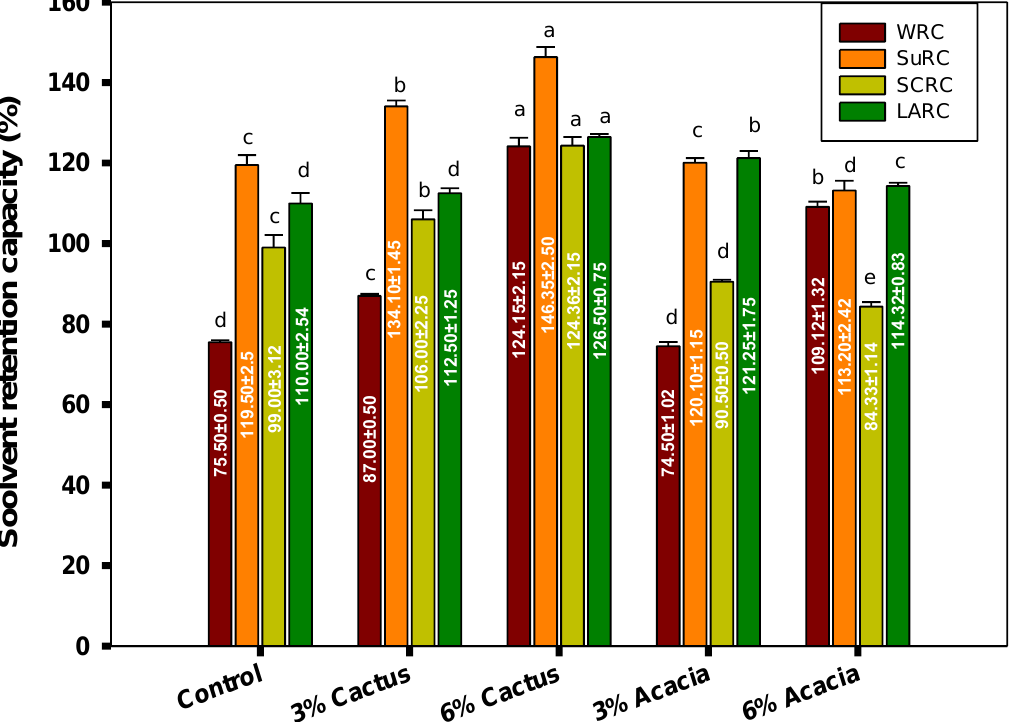
Figure 2. Solvent retention capacity of flour gum blends. WRC = water retention capacity; SuSRC = sucrose retention capacity; SCRC = sodium carbonate retention capacity; LARC = lactic acid retention capacity. Values followed by different letters in same color bars are significantly different at p < 0.05.